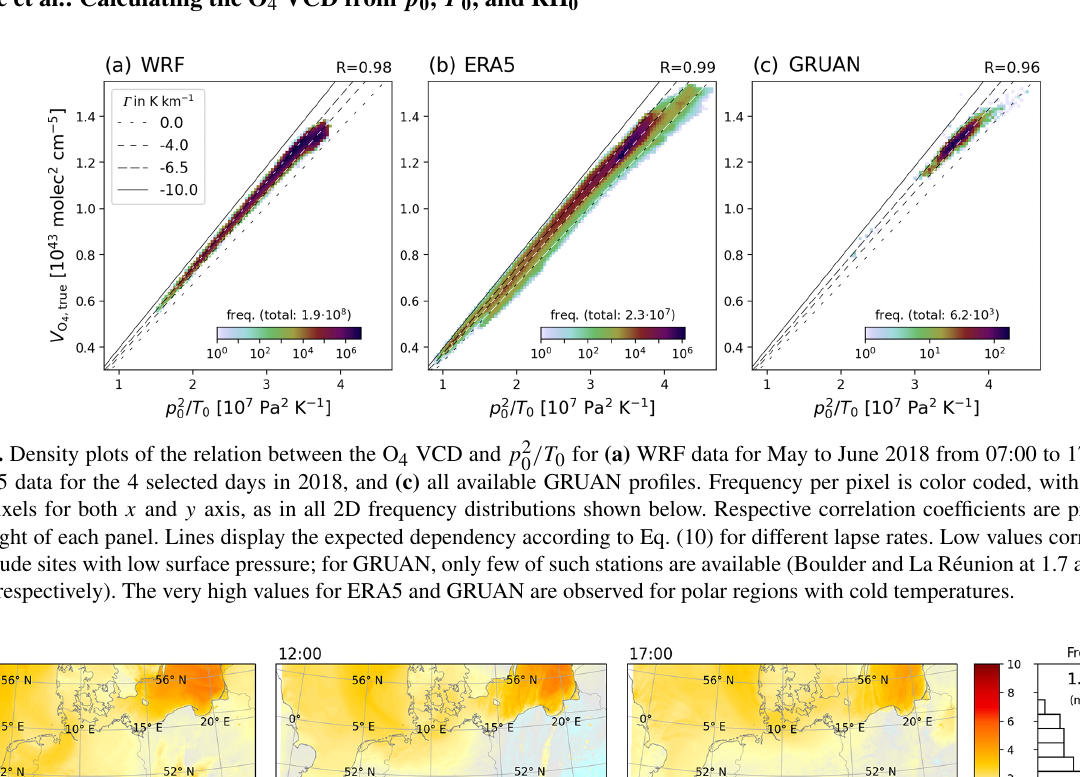
squares fit to the data presented in Fig. 5c, as shown by the black line. Fitted parameters are a = 1 . 77434 ± 0 .